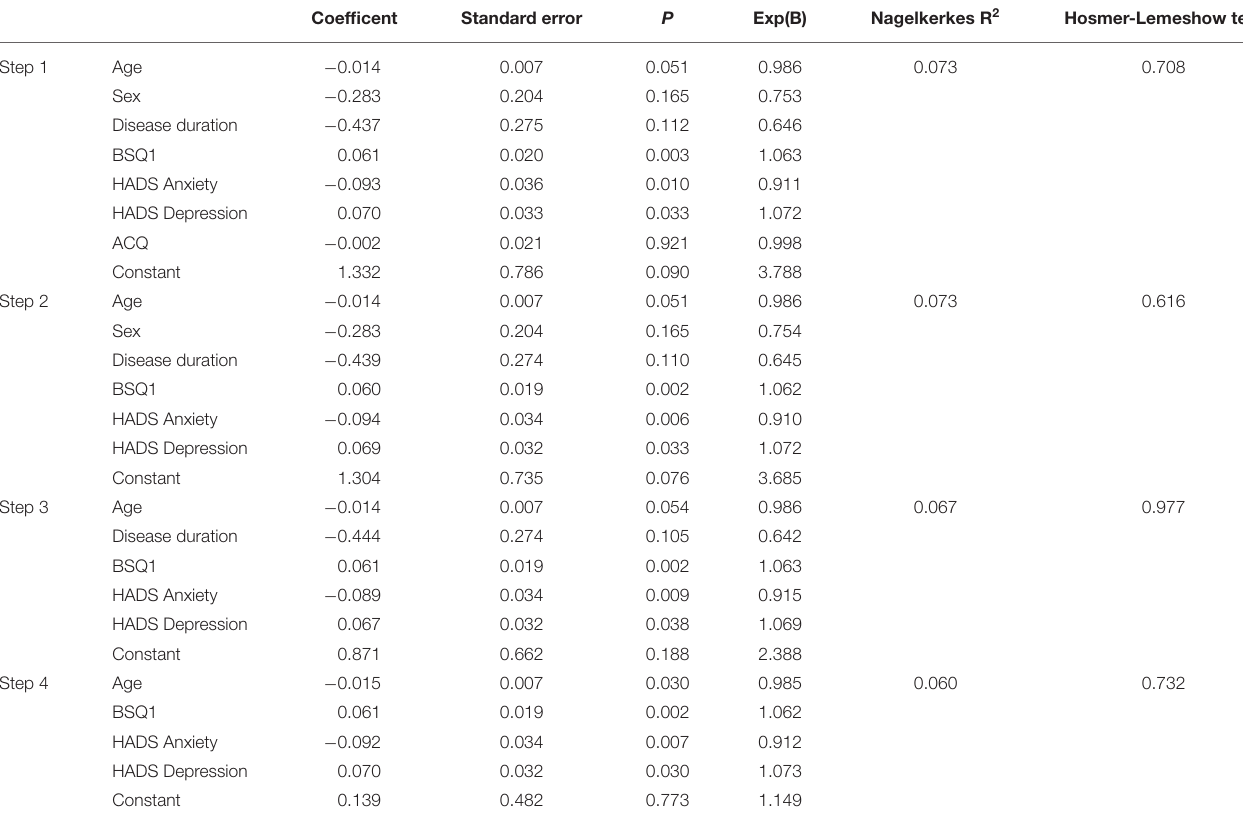
TABLE 6 | Logistic regression: predictors of hospitalization (dependent variable, backward selection).